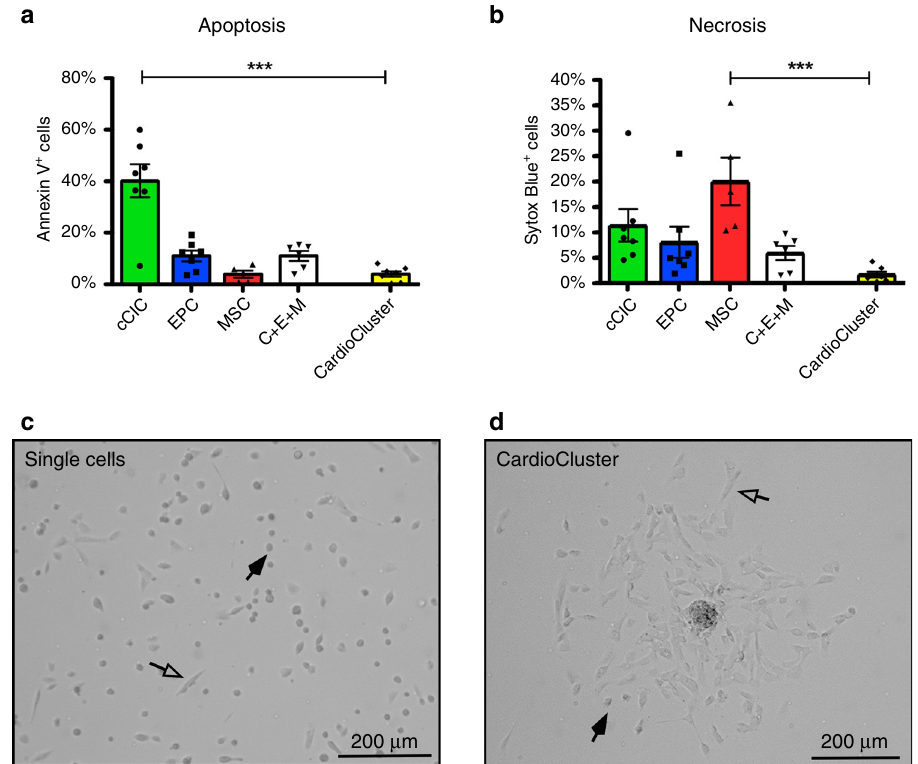
Fig. 3 CardioClusters are protective against oxidative damage. a – d Cell death assay performed on cardiac cell populations under 24 h of low serum (75% serum reduction), followed by 4 h of treatment with 30 µ M H 2 O 2 in low serum medium. a , b Apoptosis visualized by Annexin V ( a ) and necrosis visualized by Sytox Blue ( b ). Data in a and b represent mean ( n = 4 cCIC; n = 4 EPC; n = 3 MSC; n = 3 C + E + M; n = 4 CardioCluster, independent experiments run individually or in duplicate) ± SEM. Data are presented as one-way ANOVA with Dunnett ’ s comparison test, a *** p < 0.001, b *** p < 0.001, versus CardioCluster. c , d Bright fi eld images of single cells ( c ) and CardioClusters ( d ) 4 h after H 2 O 2 treatment. Transparent arrows highlight adherent (healthy) cells and black arrows highlight cells that have rounded up and detached from the tissue culture surface, most likely undergoing cell death. Source data are provided as a Source data fi